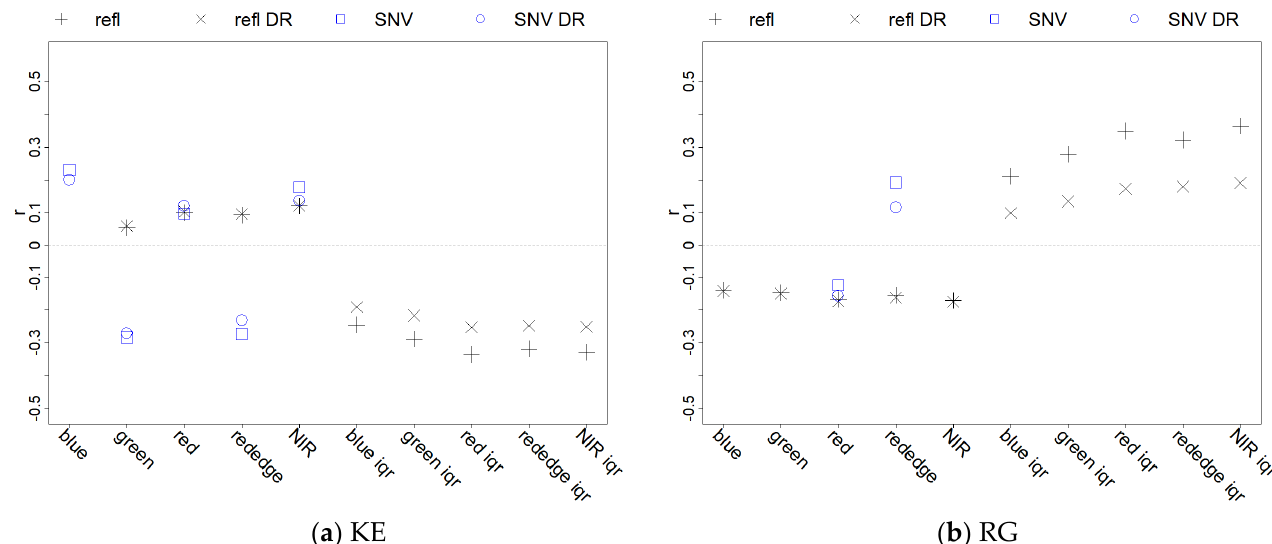
Figure 13. Correlation of the multispectral indexes with KE ( a ) and with roughness ( b ) from the 2 mm resolution dataset: “refl” represents the base dataset, “DR” the roughness threshold dataset, “SNV” the Standard Normal Variate transformation of reflectance data. Points where p < 0.05 were excluded from the plot.